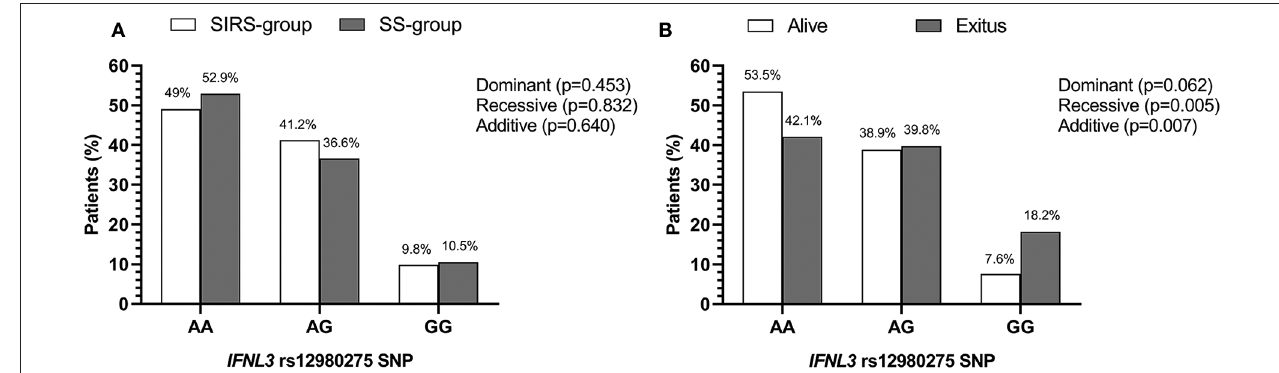
FIGURE 1 | Genetic association of IFNL3 rs12980275 polymorphism with susceptibility to septic shock and shock-related death in patients who underwent major cardiac or abdominal surgery. (A) SIRS-group vs. SS-group. (B) Alive vs. exitus patients. Statistics: P -value was calculated by logistic regression analysis. Abbreviations: IFNL3, Interferon lambda 3; SIRS, systemic inflammatory response syndrome; SS, septic shock; SNP, single nucleotide